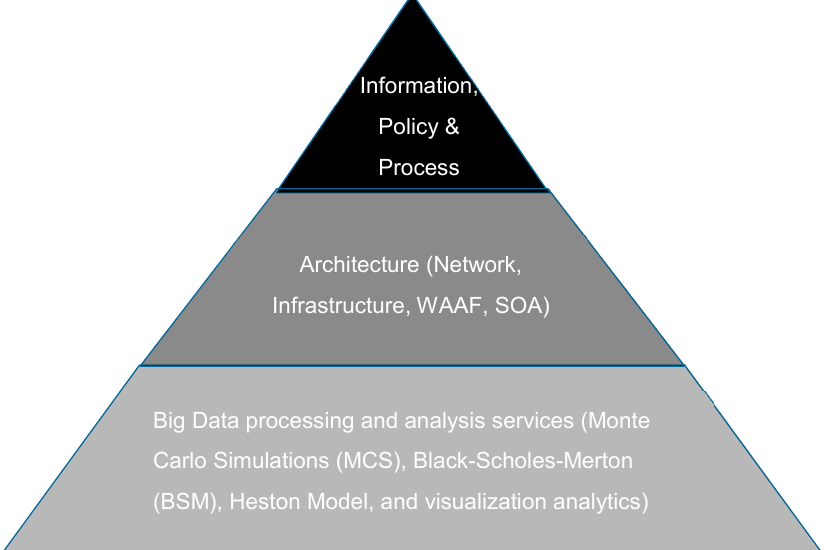
Figure 3. The Pillars of a Business Integrity-Driven Approach to Implementing Financialization.